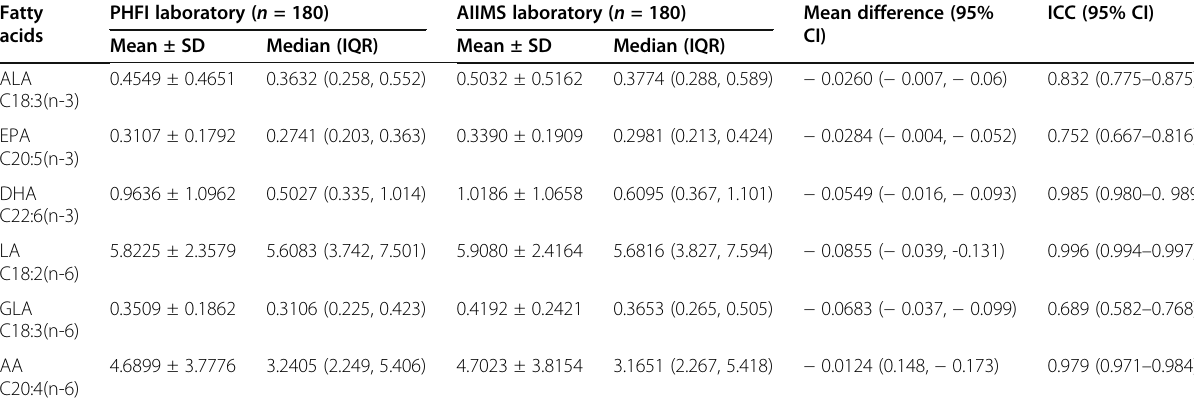
Table. 2 Agreement of analysis between the two laboratories showing intraclass correlation Fatty acids